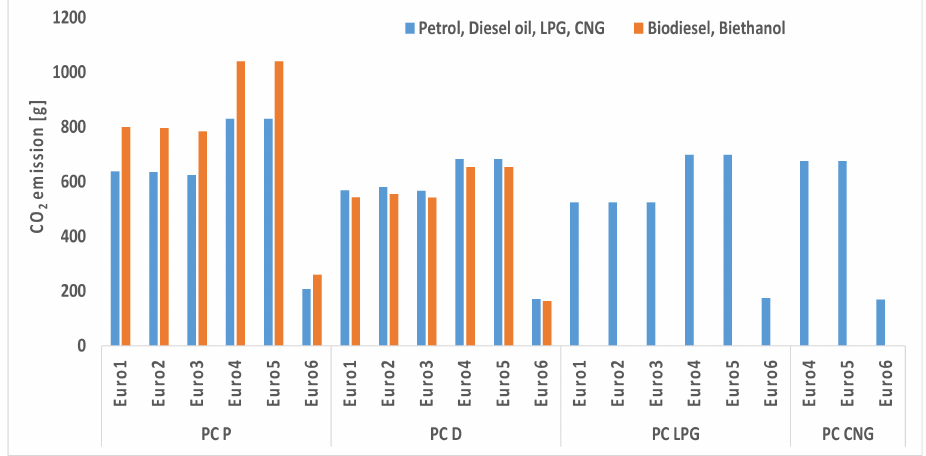
Figure 4. Comparison of CO 2 emissions from PCs depending on Euro standard and fuel type.